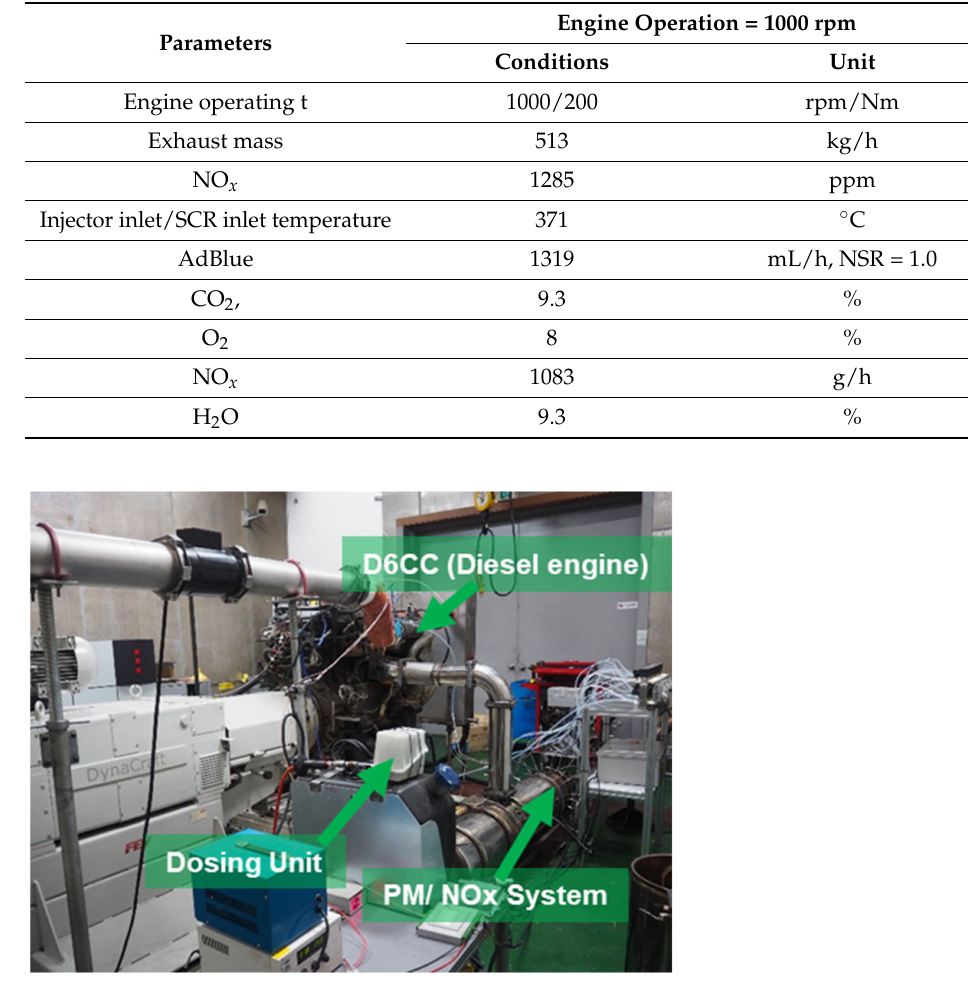
Figure 29. Experimental engine and test measurement setup adapted from Khristamto et al. [39,122].